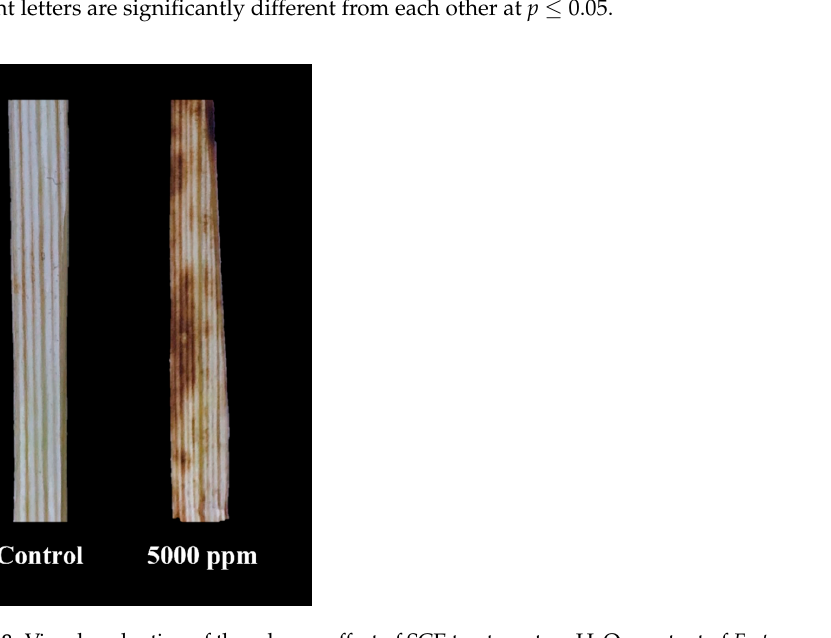
Figure 8. Visual evaluation of the adverse effect of SCE treatment on H 2 O 2 content of Festuca arundinacea.